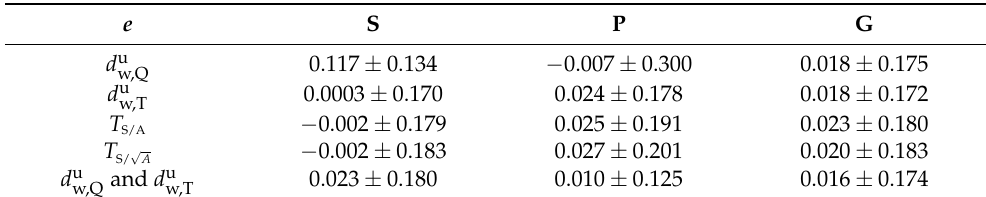
Table 7. Estimation errors ( e ) using stage-specific (S), patient-specific (P) and global (G) approach- based [ Ca 2 + ] estimators, from all patients at all HD time points. Values are expressed as mean ± standard deviation and the units are